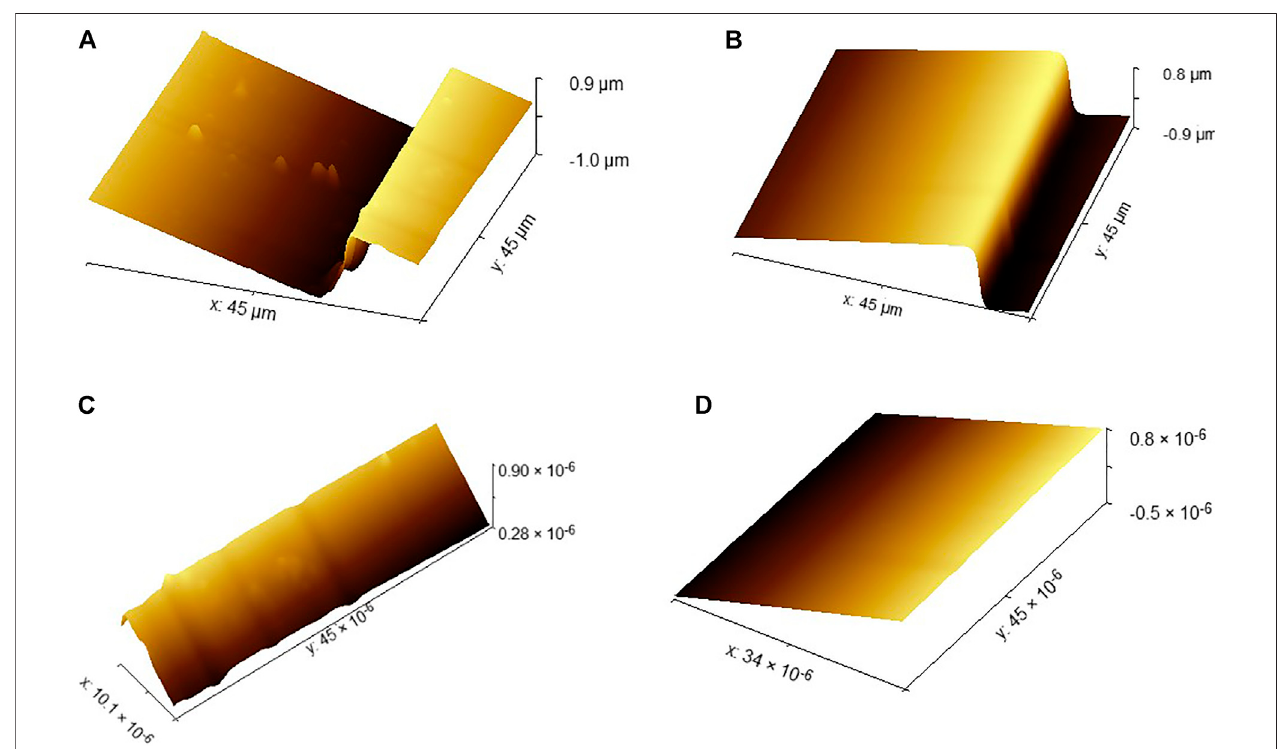
FIGURE 5 | Separation process of required step surface topography data. (A) Left SHS sample surface. (B) Right SHS sample surface. (C) Left step surface. (D) Right step